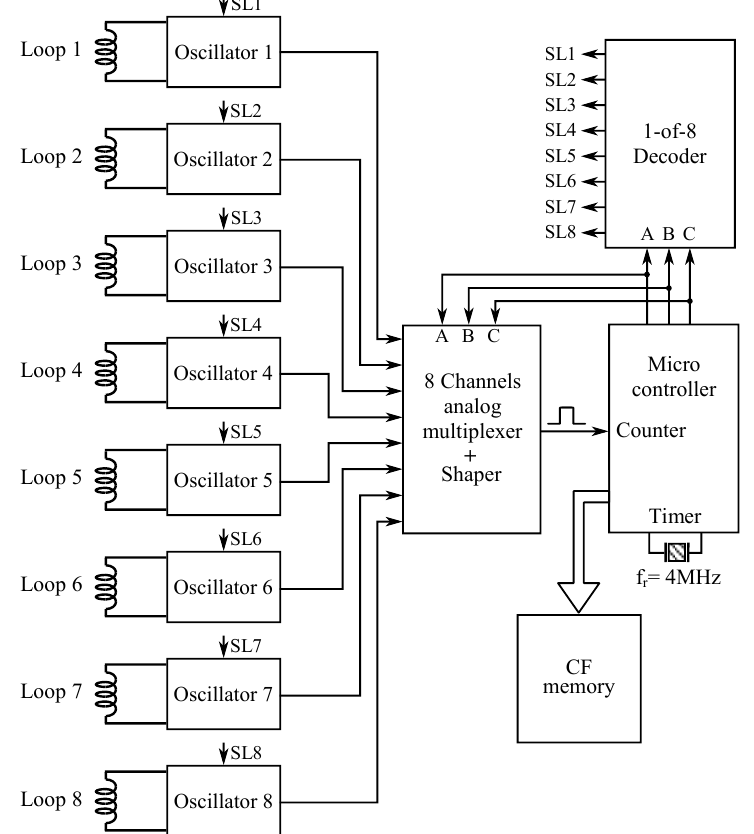
Figure 7. Multiplex system with eight inductive loops.